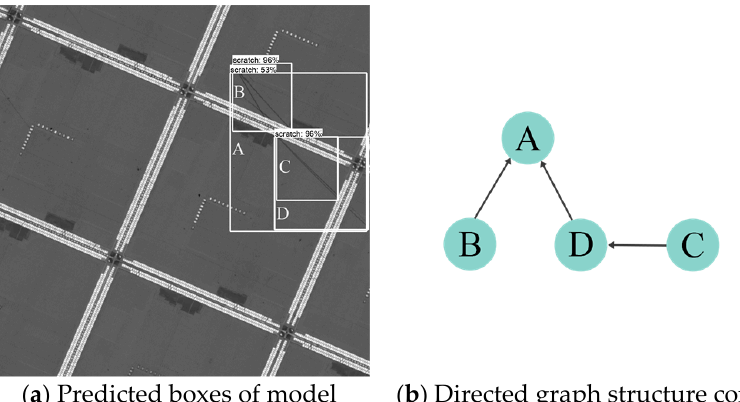
Figure 5. Example of directed-graph-structure construction.